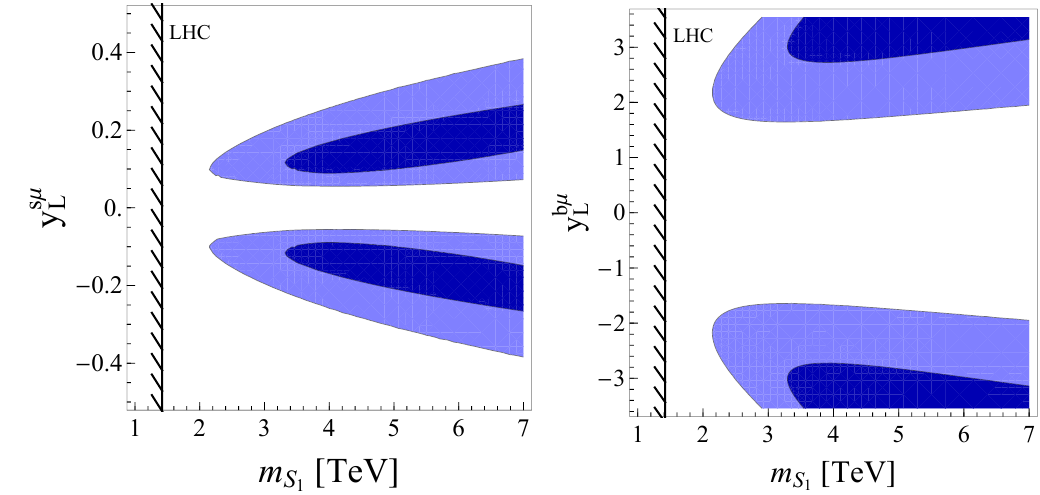
Figure 6 . m S is plotted against y s(cid:22) (left panel) and y b(cid:22) (right panel). Light (dark) blue regions L L 1 correspond to (cid:1) (cid:31) 2 < 2 : 3(6 : 8). The black line in the right panel denotes the LHC exclusion limit on pair produced LQs decaying into t(cid:22) [74]. See text for details.